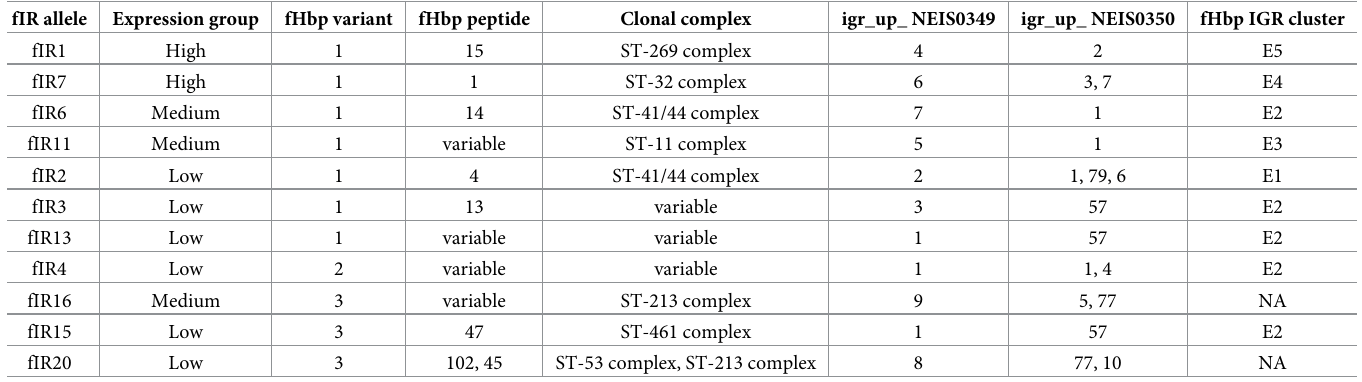
Table 1. Association between fIR alleles and fHbp peptides and clonal complexes.